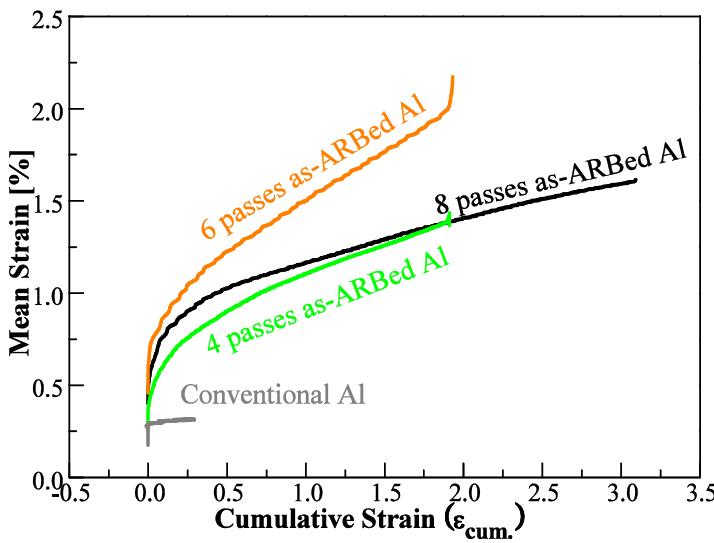
Figure 2. Plot of the mean strain of each cycle demonstrating the cyclic creep behavior of 4p, 6p, and 8p ARBed CP aluminum samples under load controlled testing with σ = 100% of the respective yield strength. The curve for conventional aluminum is also peak shown for comparison